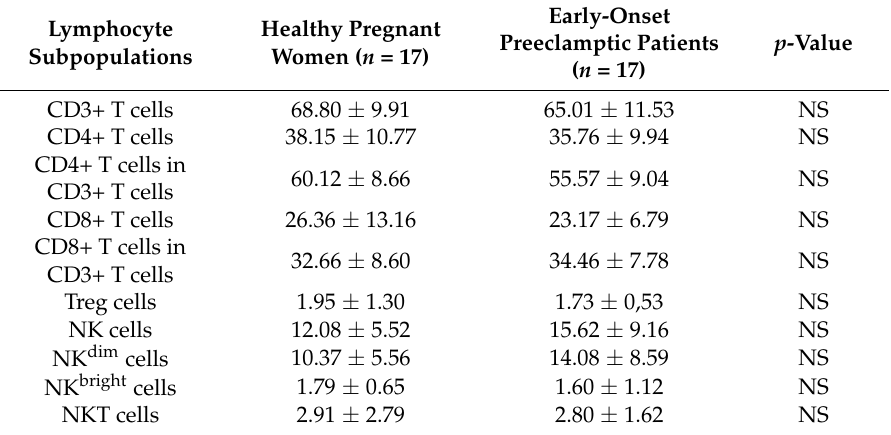
Table 1. Peripheral blood mononuclear cell phenotype characteristics in women with early-onset pre-eclampsia and in healthy pregnant